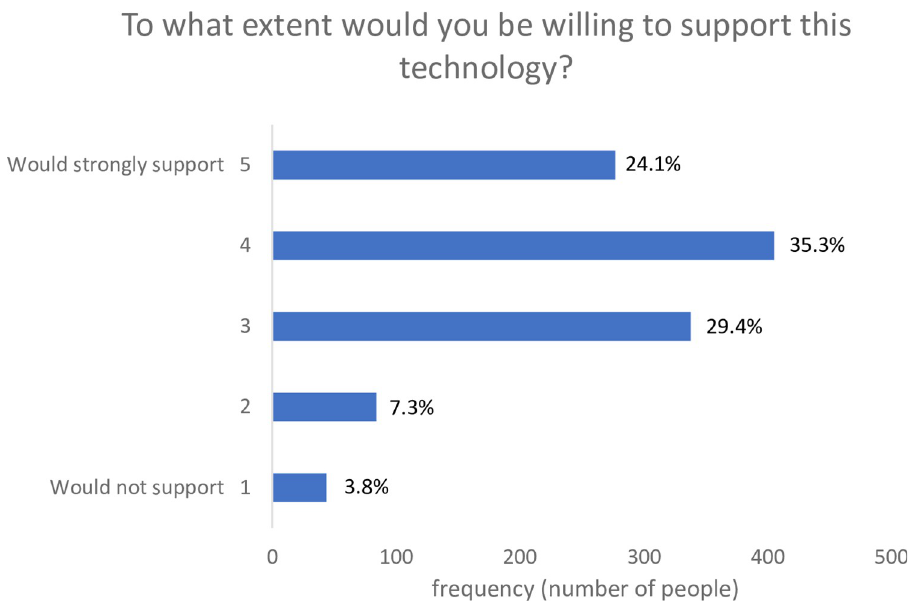
Fig 2. Support ratings for the development of the technology (N =